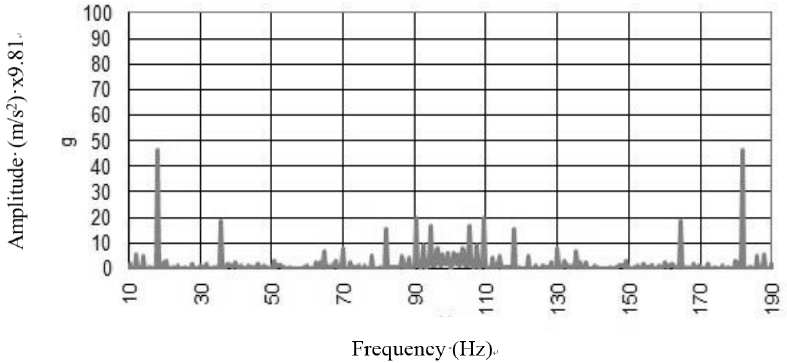
Figure 14. Free oscillations’ response to the in situ test on the damaged vault.